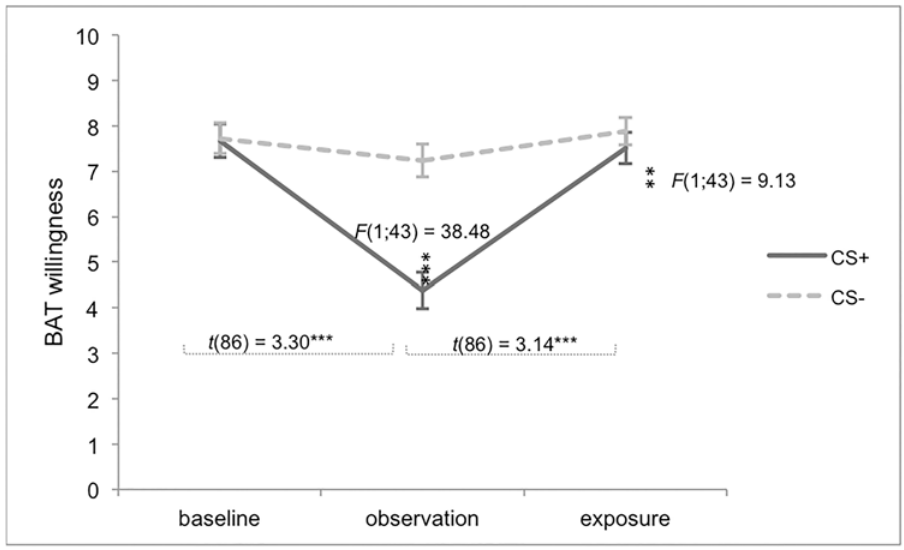
Fig 5. Self-reported behavioural avoidance tendencies in Experiment 2. Willingness to touch the metal bars. Error bars represent standard errors. BAT = Behavioural Avoidance Tendencies; * p < .05; ** p < .01; *** p <